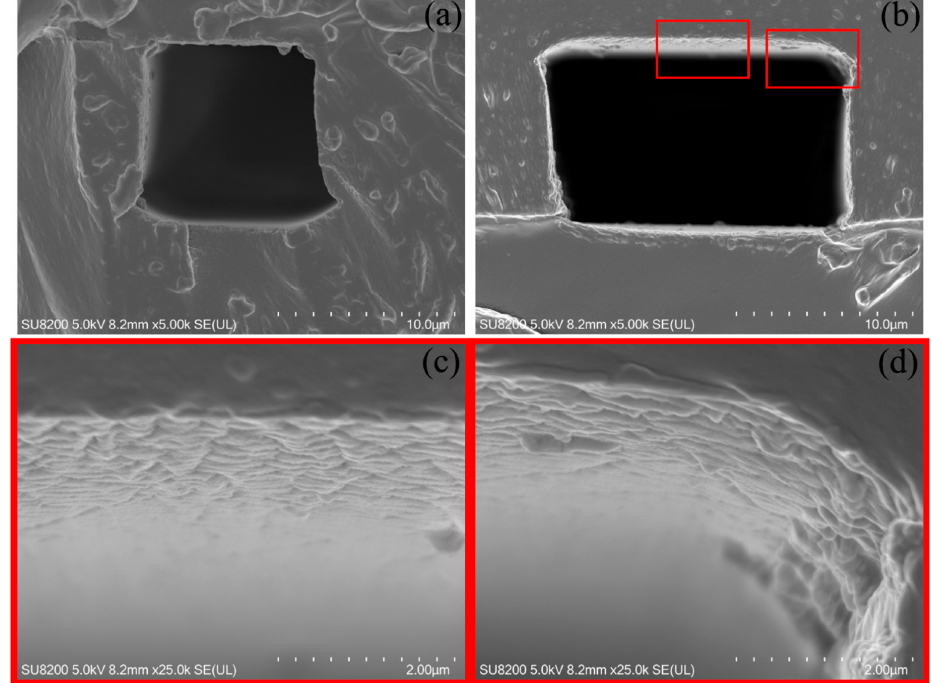
Figure 6. Images of PDMS:PDMS structures with the microchannels with the height of 12 µm taken with a Hitachi SU-8230 SEM in a case of 11-µm- ( a ) and 17-µm- ( b ) wide microchannel and highlighted the regions in which the images with the higher magnification were taken, representing a top surface ( c ) and a top corner ( d ) of the microchannel. The width difference at the top and bottom of the channels is about 2 µm.